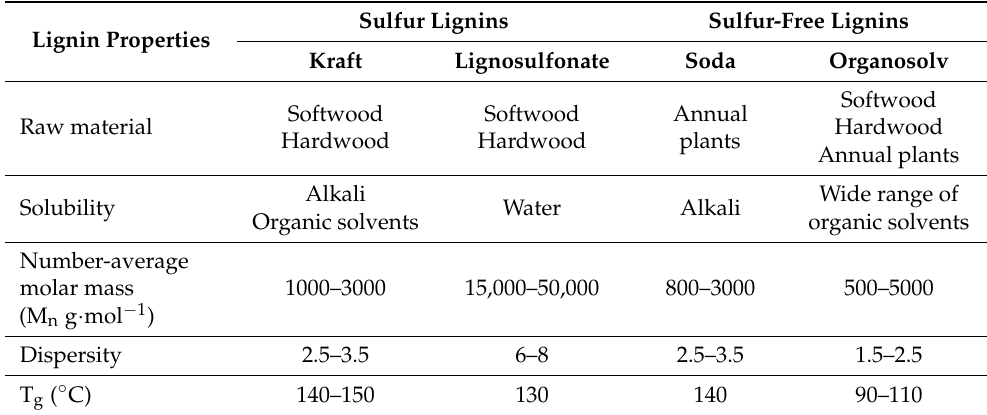
Table 3. Typical properties of technical lignin. Reproduced from [9], with the permission of